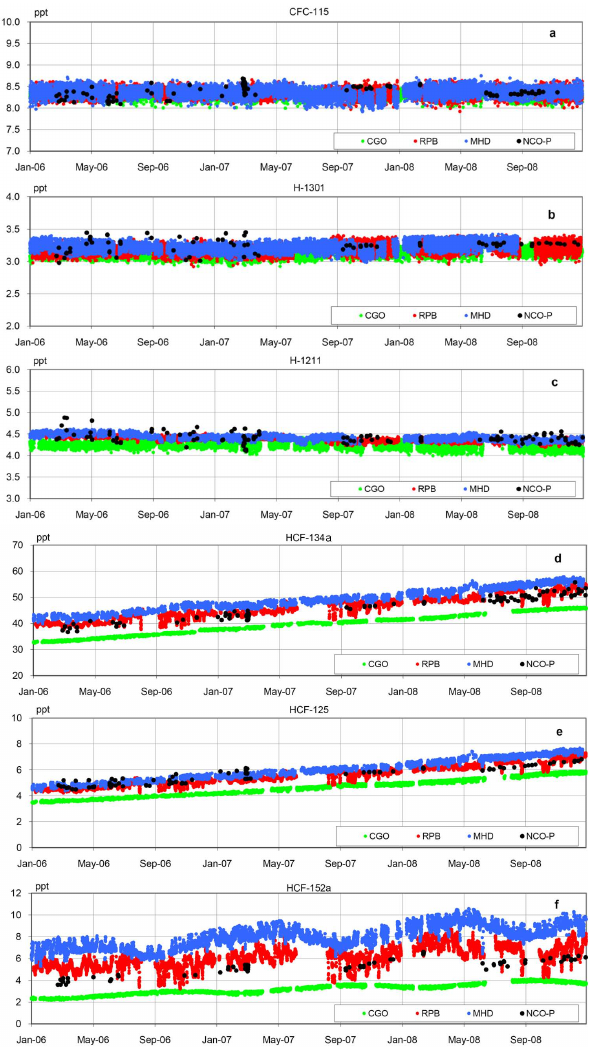
Fig. 5. Meridional gradients: time series for (a) CFC-115, (b) H- 1301, (c) H-1211, (d) HFC-134a, (e) HFC-125 and (f) HFC-152 at NCO-P (black) are reported together with those obtained at MHD (blue), RPB (red) and CGO (green). Only baseline data have been considered.